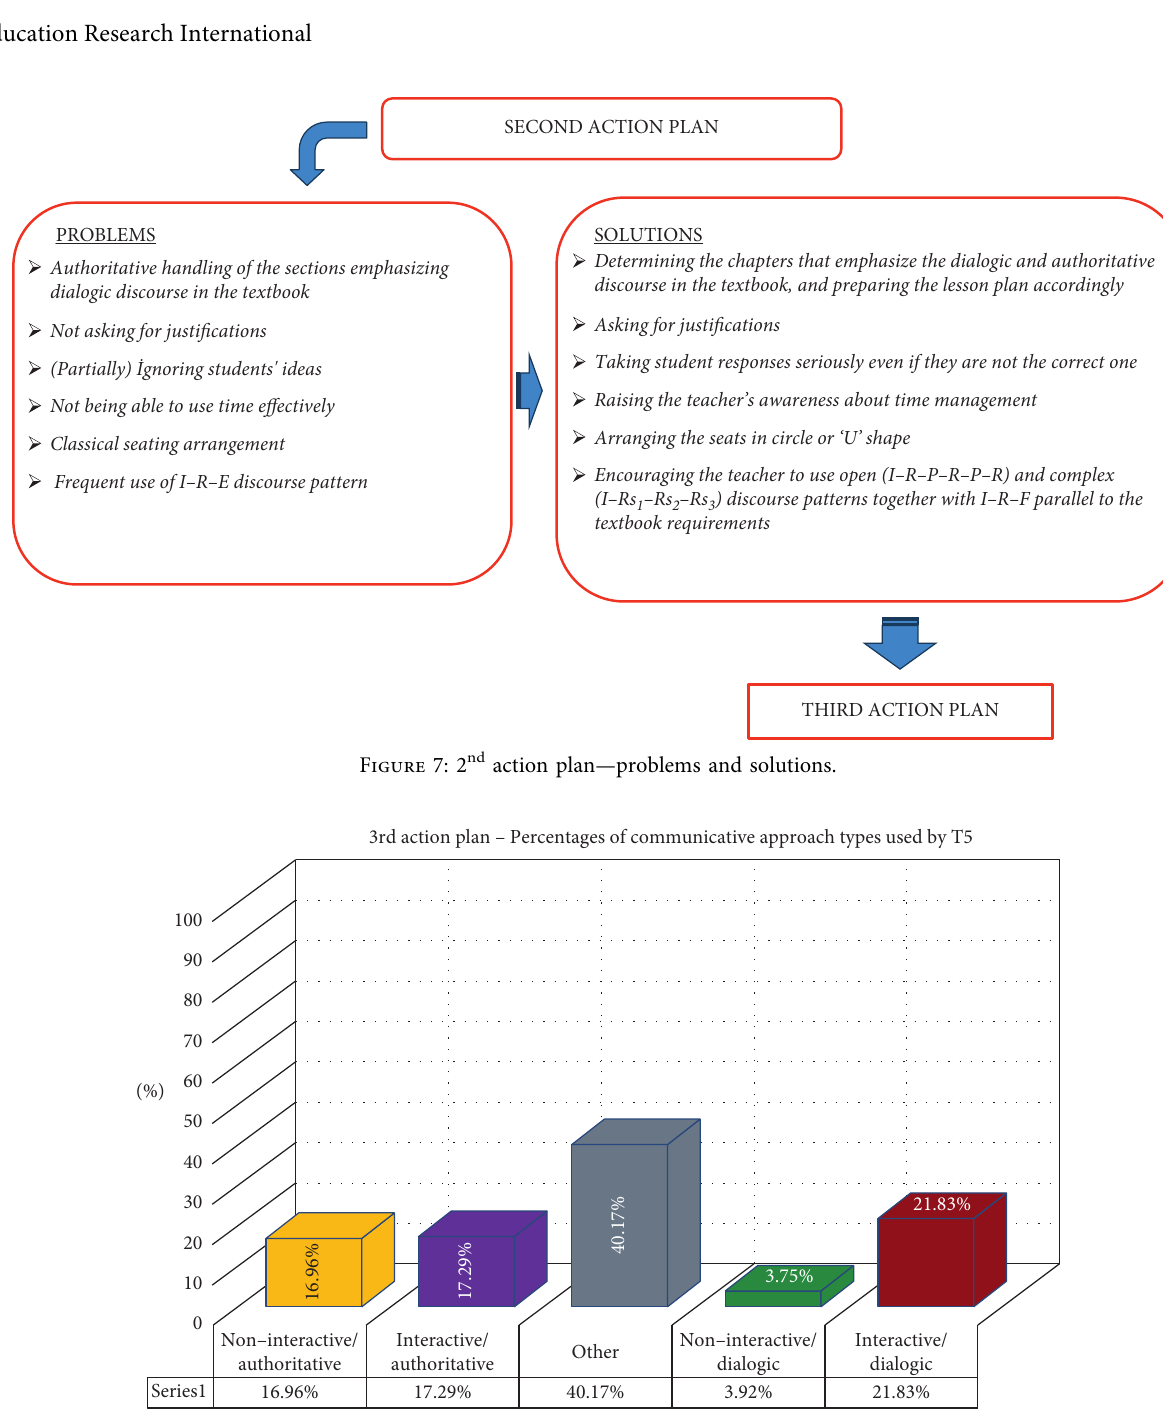
Figure 8: 3 rd action plan—percentages of communicative approach types used by